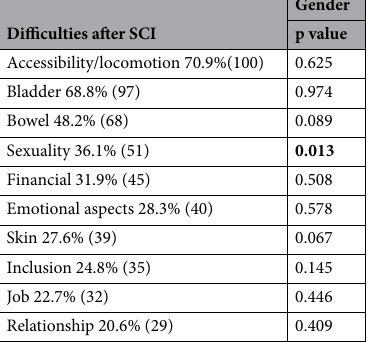
Difficulties after SCI